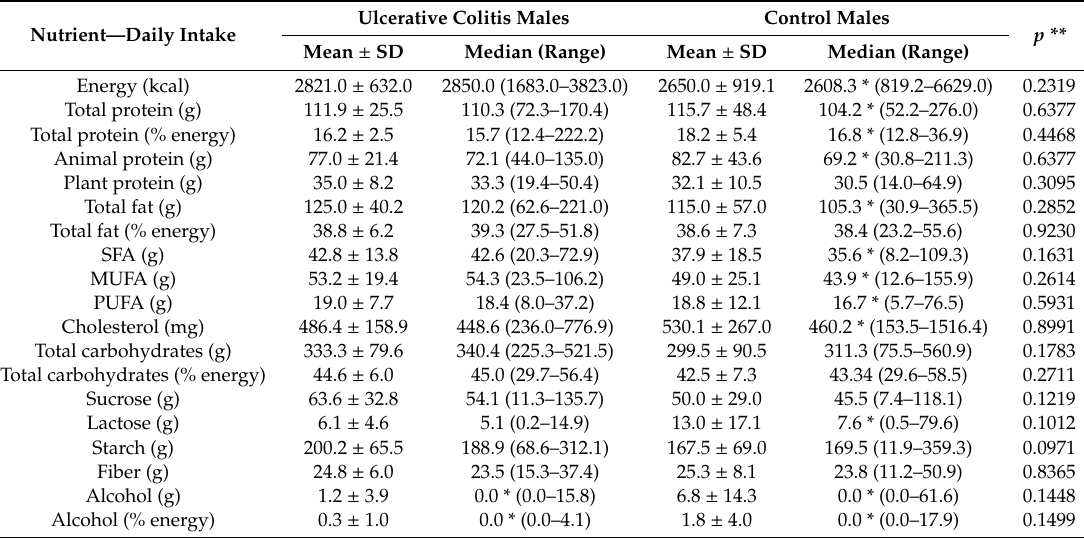
Table 1. The macronutrients intake in ulcerative colitis males and control